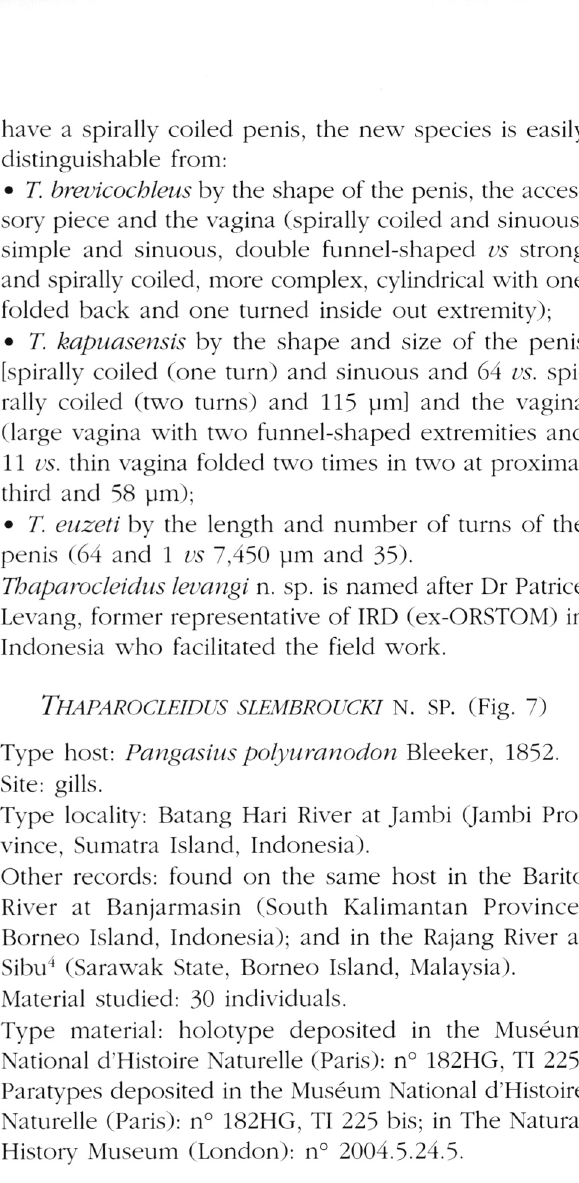
rounded cupule-like staicture (21 ±3.1 (14-27) at its width), no visible heel: Pe = 93 ± 12.2 (72-111). Simple ture near to penis attachment: Ap = 32 ± 5 (24-42).